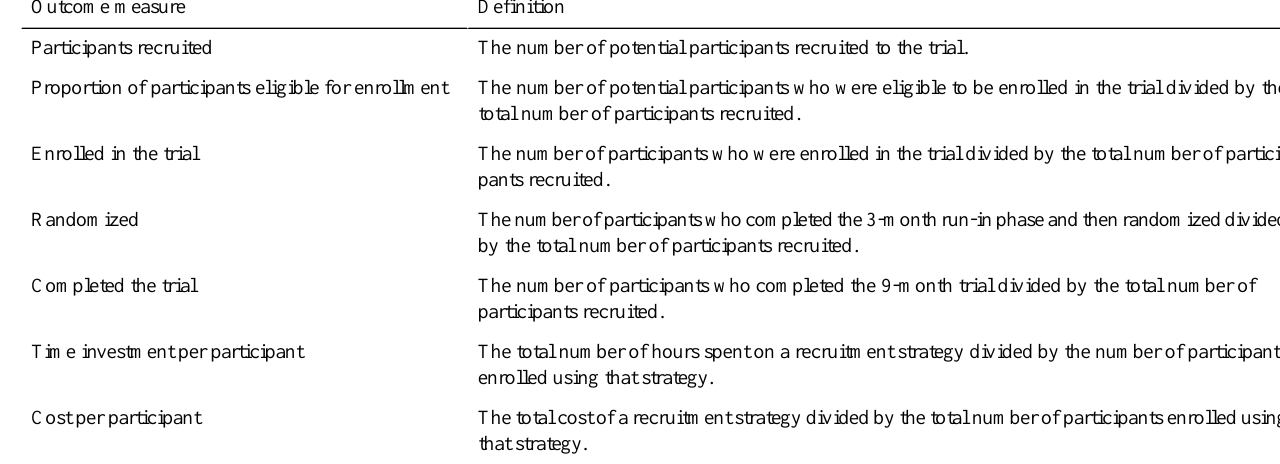
Table 1. Outcome measure definitions. DefinitionOutcome measure